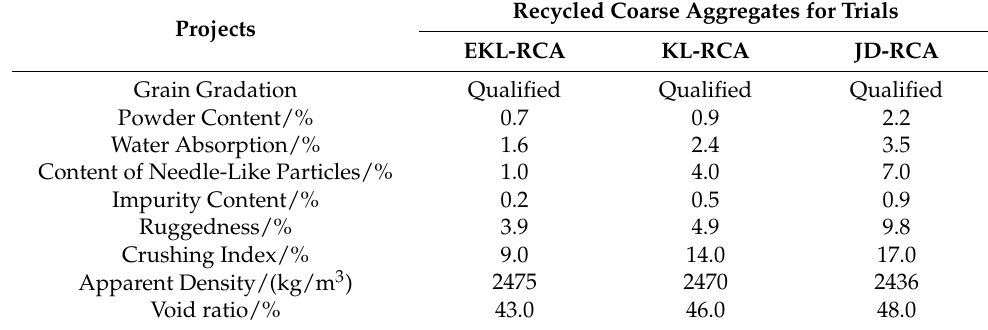
Table 5. Performance indexes of three kinds of RCA.